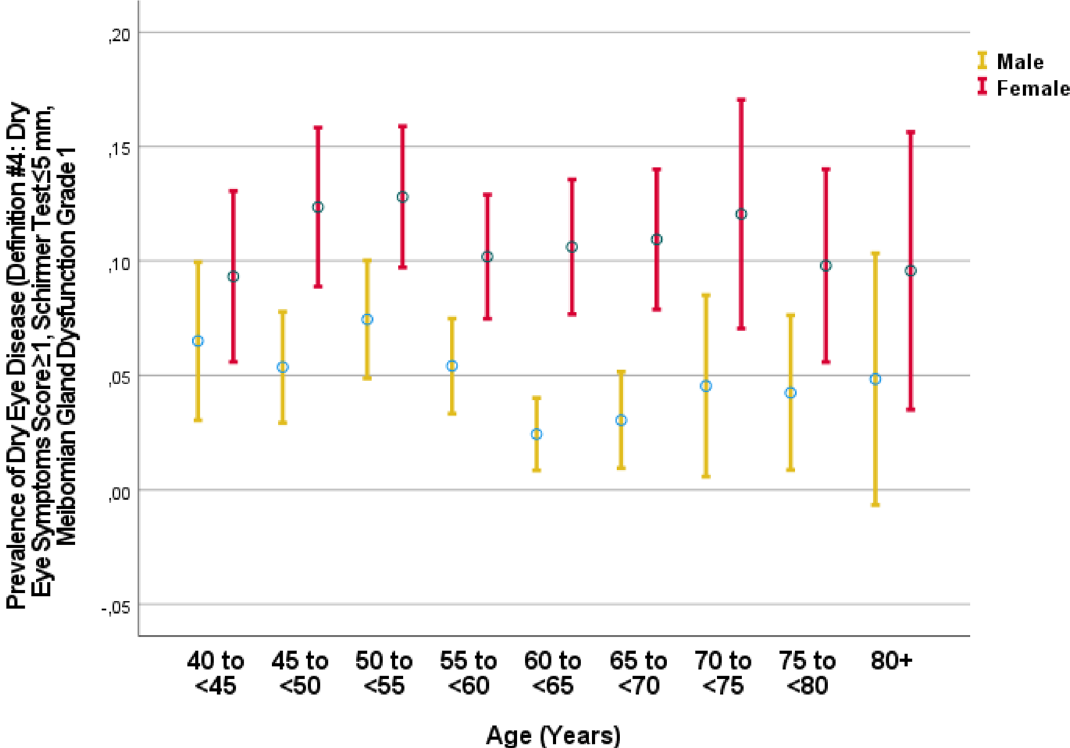
Figure 4. Graph showing the distribution of the prevalence of dry eye disease (definition #2: dry eye symptoms score was ≥ 2 and Schirmer´s test of < 5 mm) stratified by age in the Ural Eye and Medical Study.